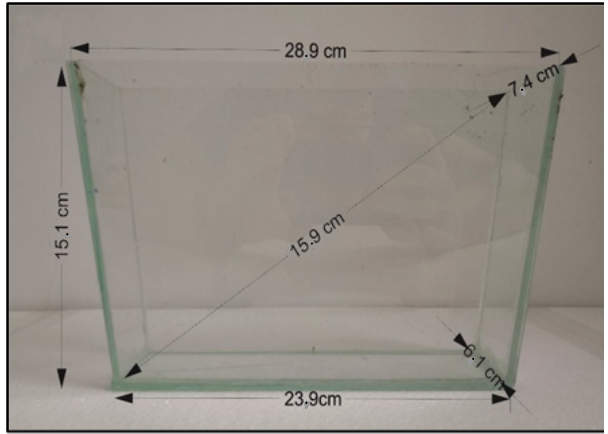
Figure 6. The NTT trapezoidal shaped glass.